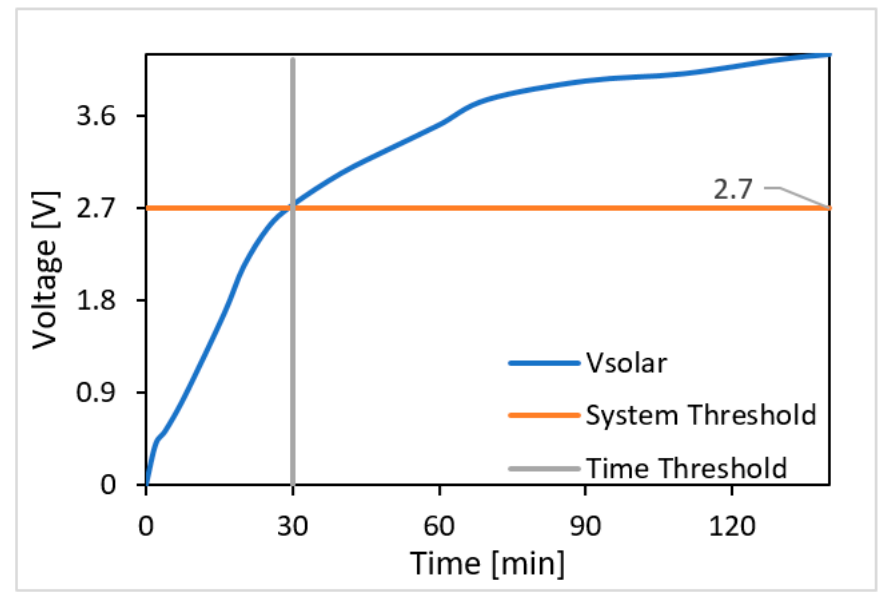
Figure 4. Voltage in the capacitor with solar energy (blue trace). Thresholds refer to the working limit. The cross between the vertical line (grey trace, 30 minutes) and the horizontal line (orange trace, 2.7 V) is when the system starts to work.